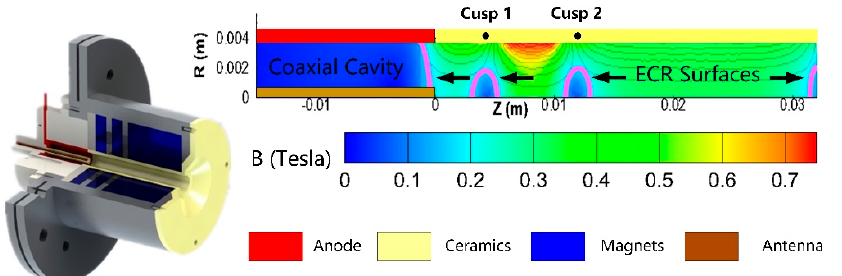
Figure 19. First-generation microwave discharge cusped field thruster, with several ECR surfaces marked